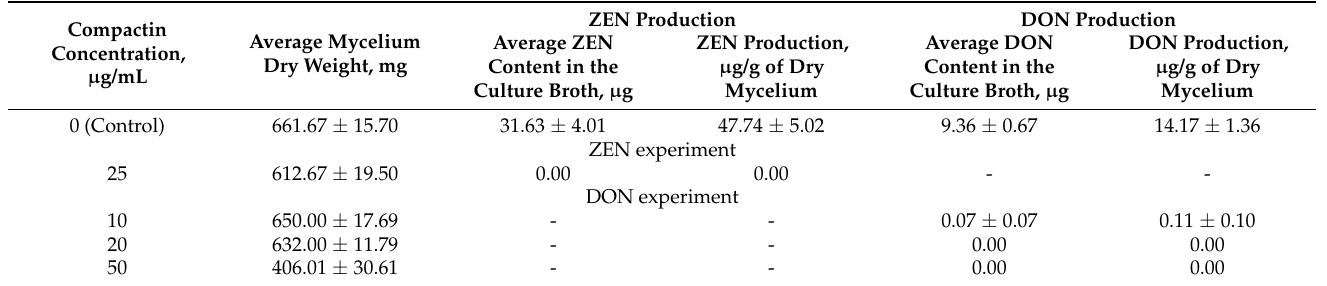
Table 1. Effect of compactin on the zearalenone (ZEN) and deoxynivalenol (DON) production by F. culmorum FC-19 1 .